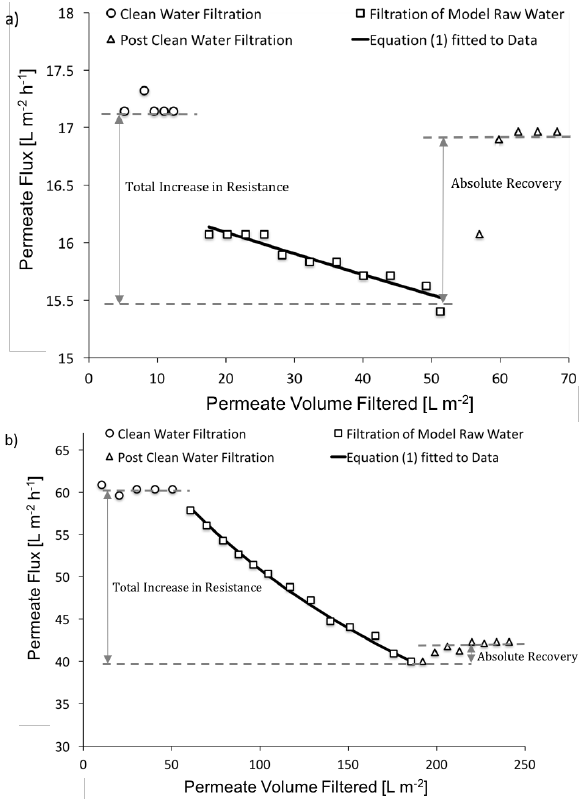
Figure 3. Typical results from filtration tests: ( a ) MWCO = 300 Da and SRNOM at 5 mg/L of DOC, ( b ) MWCO = 8000 Da and alginate at 5 mg/L of DOC.